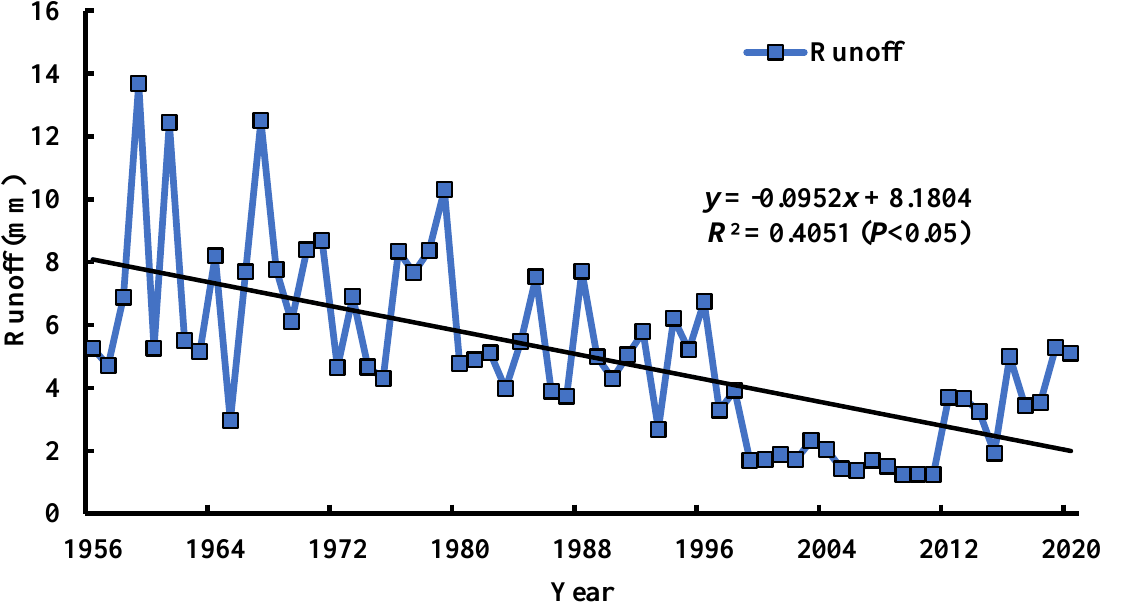
Figure 9. Change trending chart of the annual runoff in the Kuye River Basin from 1956 to 2020 .